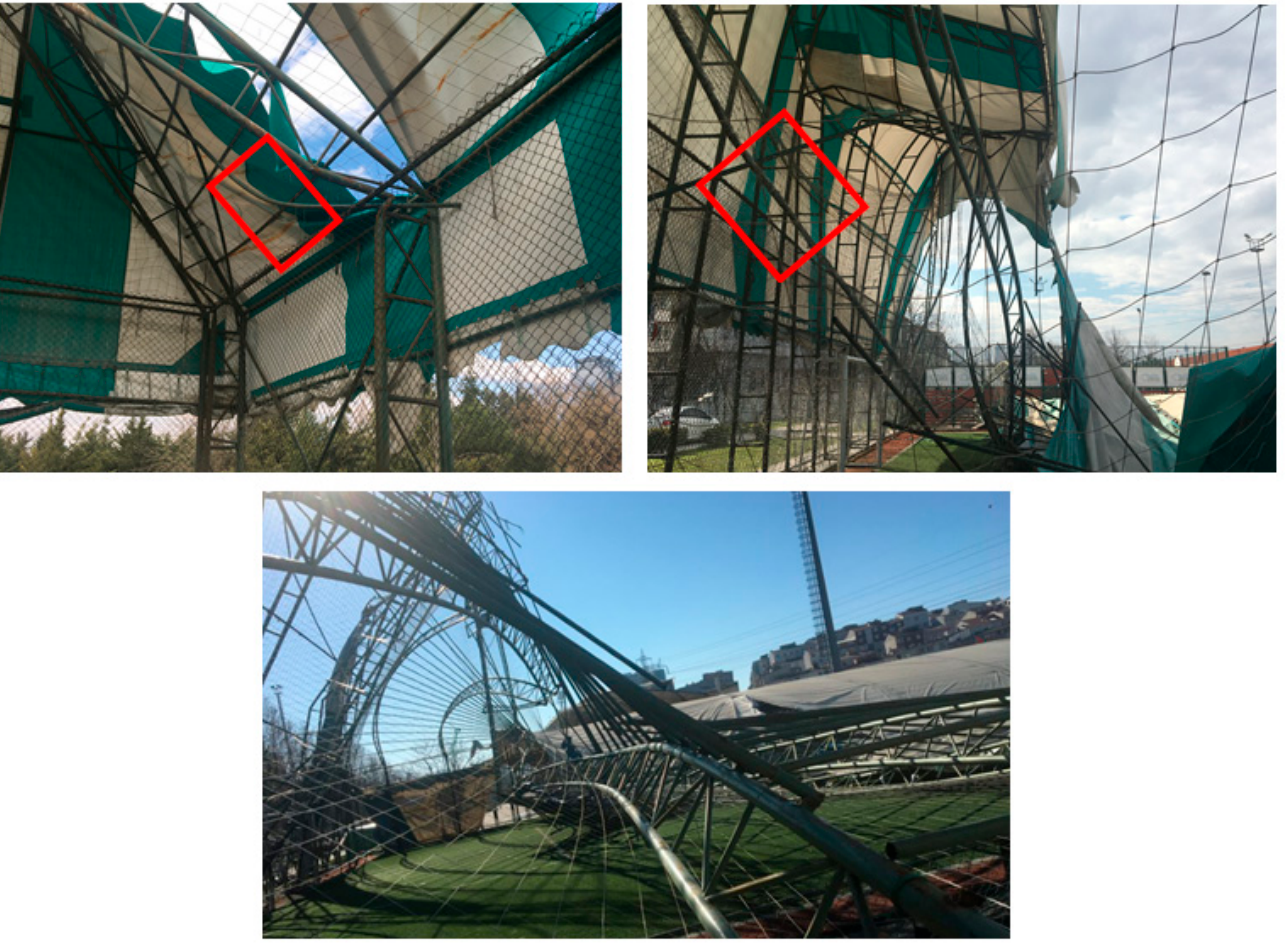
Figure 6. Roof and façade wind stability braces.